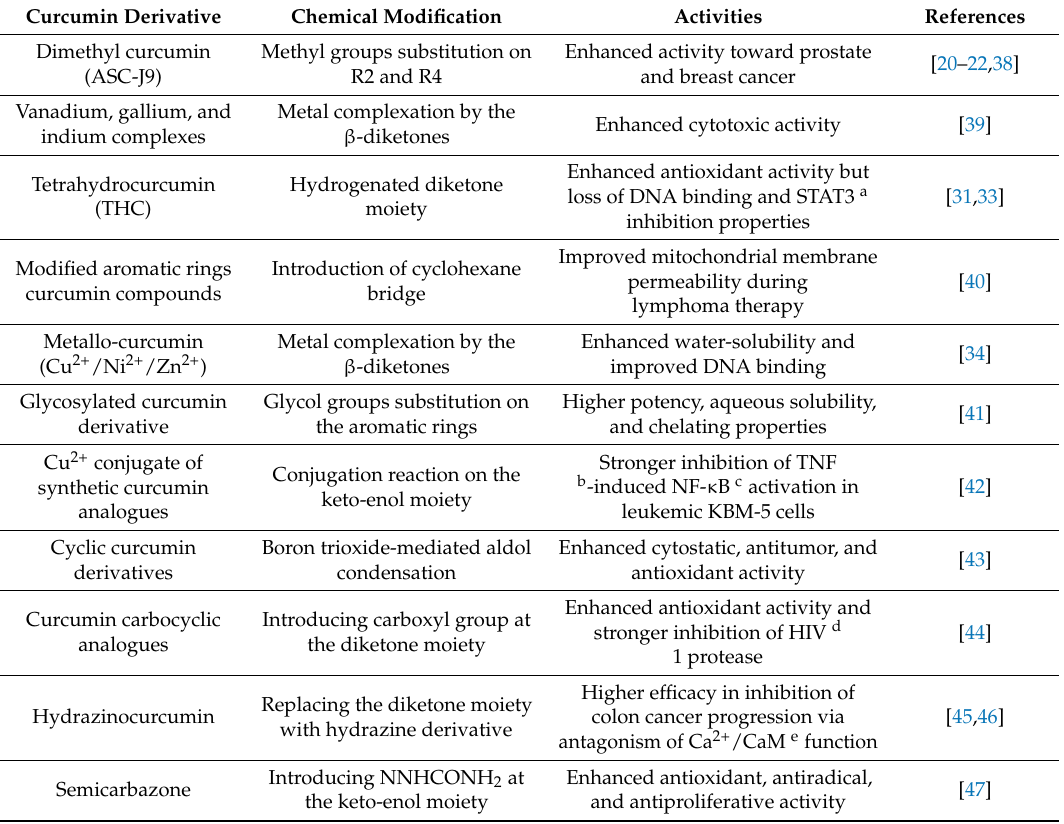
Table 1. Changes to the pharmacological activity of curcumin derivatives compared to